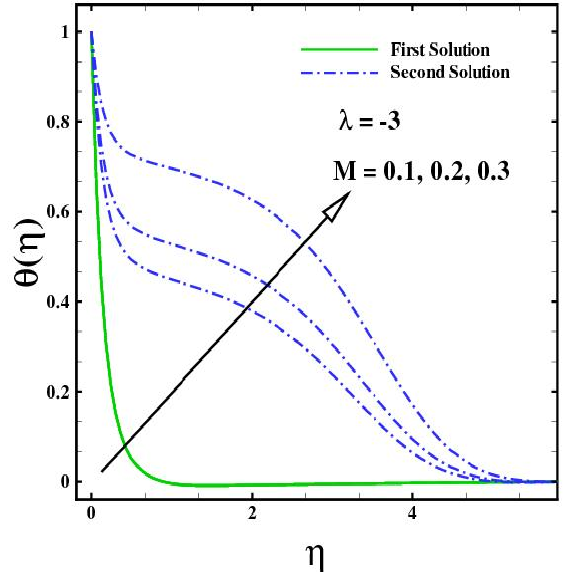
Figure 12. Impact of temperature with several values of M and We = β = 0.3, S = 4, Ec = A = B = 0.01, and Pr = n = 2.